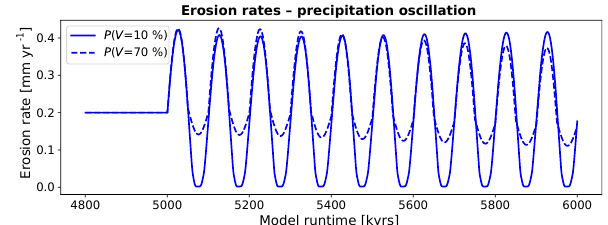
Figure 13. Mean catchment erosion rates for simulations with os- cillating mean annual precipitation and constant surface vegetation cover. The amplitude of change in the erosion rates varies with the initial vegetation cover, in part due to the nonlinear relationship be- tween precipitation and vegetation cover (Figs. 4,